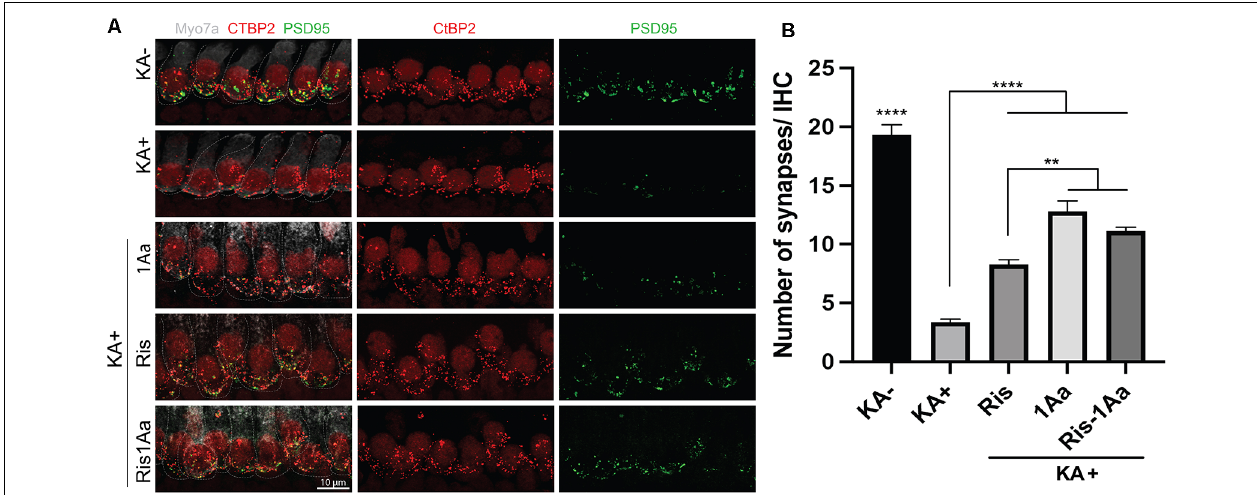
FIGURE 8 | Ris-1Aa promotes synapse regeneration in vitro . (A) Immunohistochemistry of untreated control (KA-), control treated with KA (KA+), explant treated with KA+ 1Aa, explant treated with KA+ Ris, and explant treated with KA and Ris-1Aa. Hair cells were labeled with Myo7A (white), presynaptic ribbon synapse was labeled with CtBP2 (red), and postsynaptic ribbon synapse was stained with PSD95 (green). Images are representative of 10 independent experiments. Scale bar represents 10 µm. (B) Quantification of synapses per inner hair cell for various treatment conditions ( ∗∗∗∗ p ≤ 0.0001, denotes that counted synapses in both KA- and KA+ were statistically significant relative to all other samples; ∗∗ p ≤